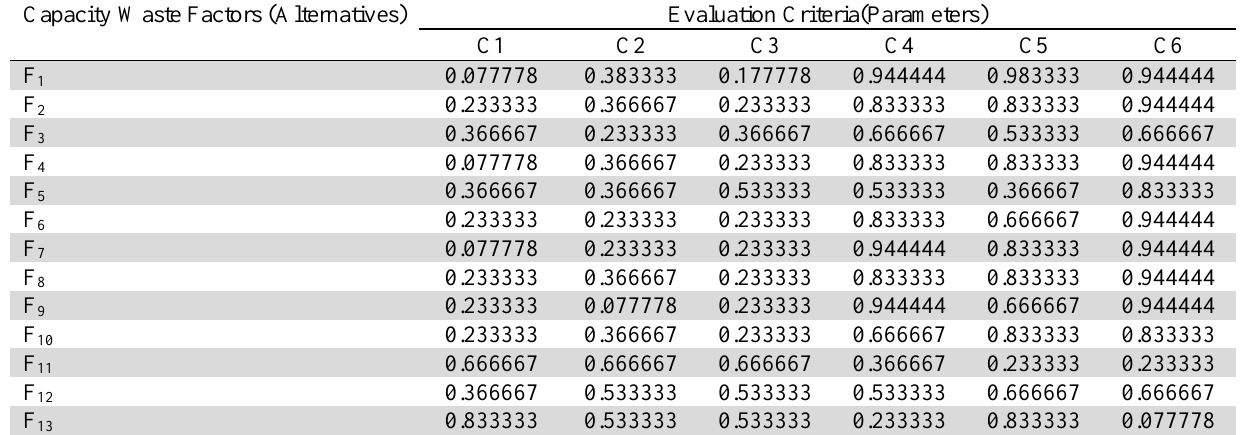
Calculated crisp values for assigned fuzzy rates Capacity Waste Factors (Alternatives)